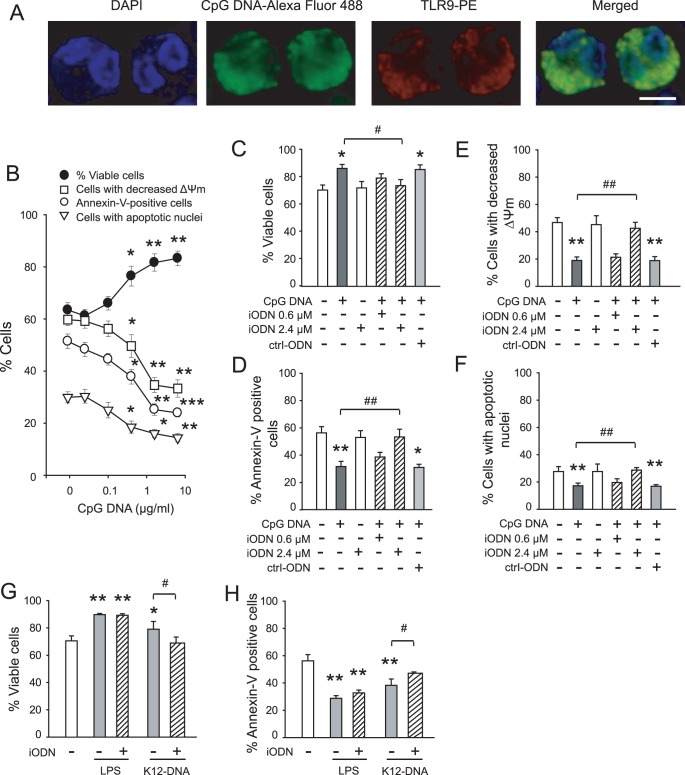
Bacterial DNA delays apoptosis of human neutrophils through TLR9.(A) Co-localisation of CpG DNA and TLR9. Neutrophils were incubated with Alexa Fluor 488-labeled CpG DNA and then stained with R-PE-conjugated anti-TLR9 eB72-1665 and 4′,6-diamidino-2-phenylindole (DAPI). Images were captured using a Leica DMRI fluorescence microscope and are representative of 3 neutrophil preparations from different blood donors. Scale bar: 10 µm. (B) Concentration-dependence of the effects of CpG DNA on neutrophil apoptosis. Neutrophils (5×106 cells/ml) were cultured for 24 h with increasing concentrations of CpG DNA and viability (propidium iodide staining), mitochondrial transmembrane potential (ΔΨm) (CMXRos staining) and apoptosis (annexin-V-FITC binding and nuclear DNA content) were assessed. (C–F) Telomere-derived iODN inhibits the actions of CpG DNA. Neutrophils were incubated for 10 min with iODN (0.6 or 2.4 µM) or ctlr-ODN (2.4 µM) and then challenged with CpG DNA (1.6 µg/ml) for 24 h. (G, H) K12-DNA delays neutrophil apoptosis. Neutrophils were cultured for 24 h with LPS-free K-12-DNA (1.6 µg/ml) or ultra pure LPS (1 µg/ml) and viability (G) and annexin-V-FITC binding (H) were assessed. Data are means ±SEM (n = 3–5). *P<0.05; **P<0.01; ***P<0.001 vs. untreated. #P<0.05; ##P<0.01.